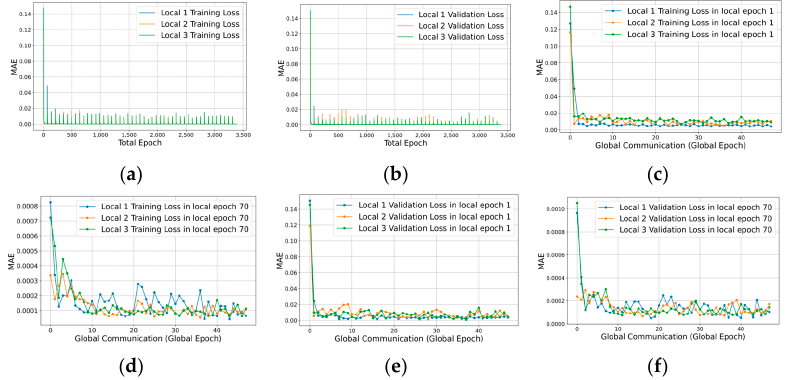
Figure 6. FL training results in training ( a ): validation loss ( b ), training loss at local epochs 1 and 70 ( c , d ), and validation loss at local epochs 1 and 70 ( e , f ). Table 3. Average MAE result for local combinations. Local 1 Local 2 Local 3 FedAvg ( L 1 , L 2 , L 3 )